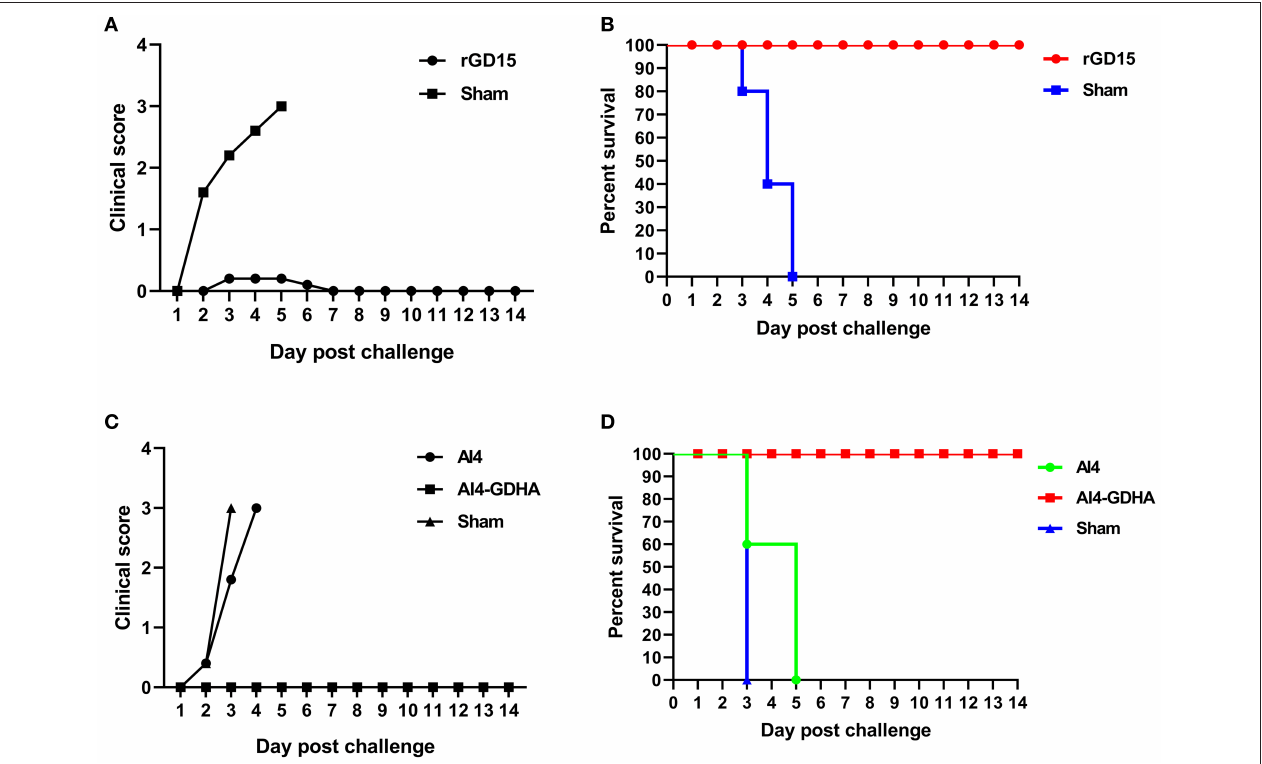
FIGURE 4 | Clinical scoring and survival of animals after H7N9 challenge. (A) Clinical scoring and (B) survival of chickens immunized with the rGD15 vaccine. (C) Clinical scoring and (D) survival of chickens immunized with the NDV-H7N9 vaccine.